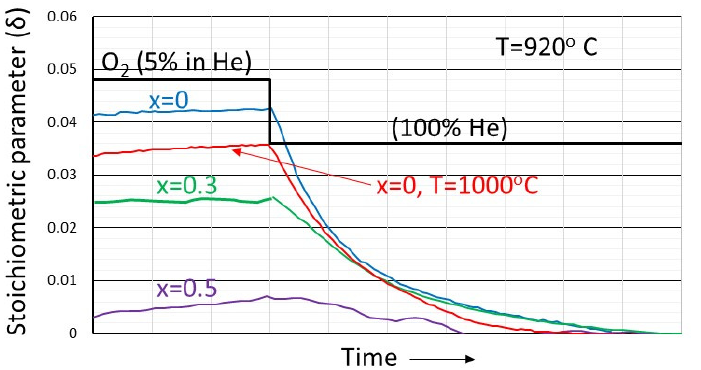
Figure 5. The dependence of the stoichiometric parameter δ in La 1 − x Ca x MnO 3+ δ perovskites as a function of x, initially equilibrated in helium at constant temperature and subsequently subjected to a 100% helium atmosphere.